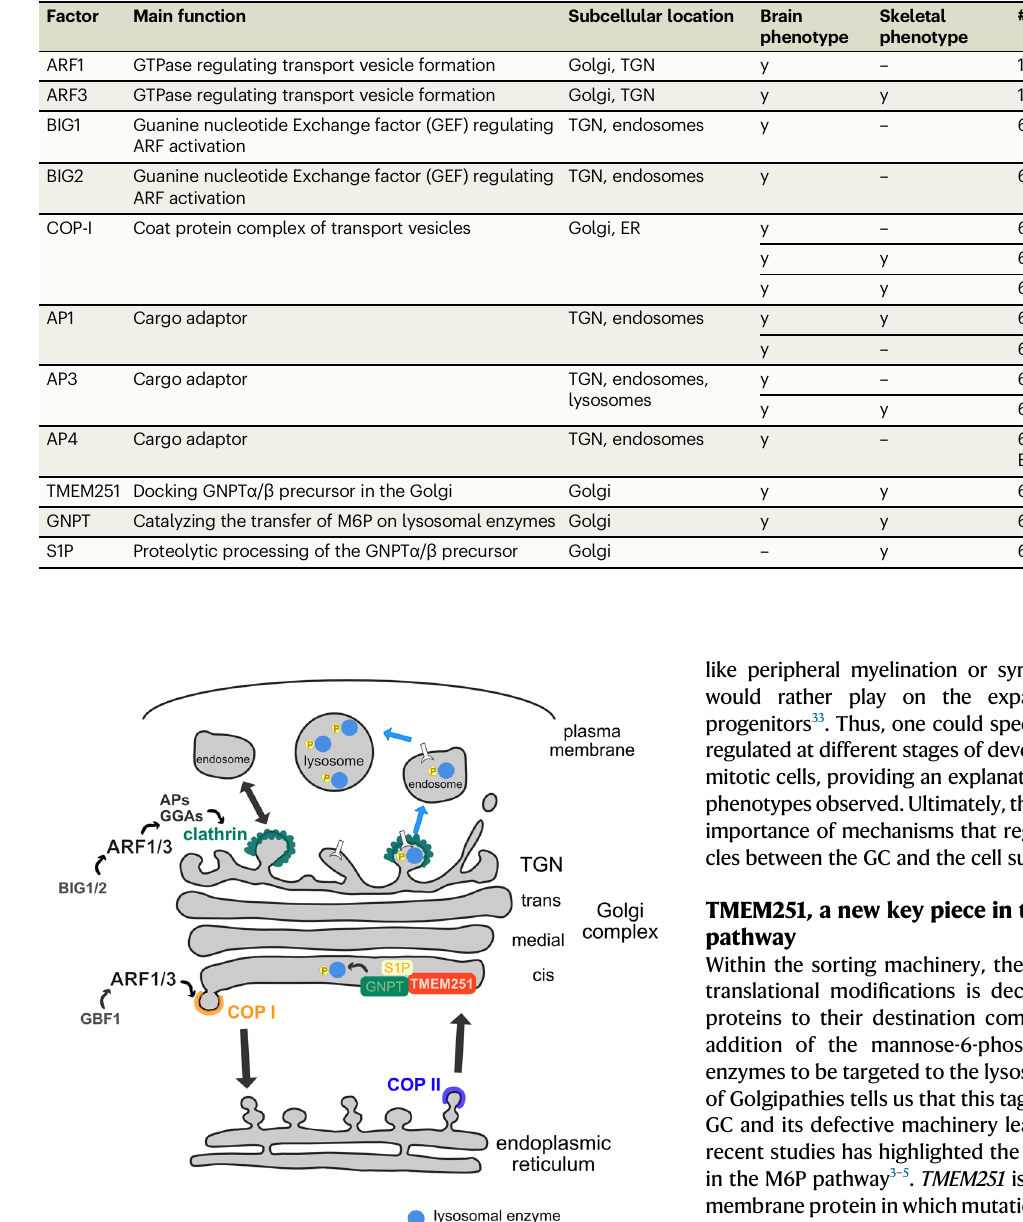
Table 1 | ARF1/3 partners and factors of the M6P pathway associated with human developmental diseases including brain and/ or skeletal defects (y = yes; - = not reported)